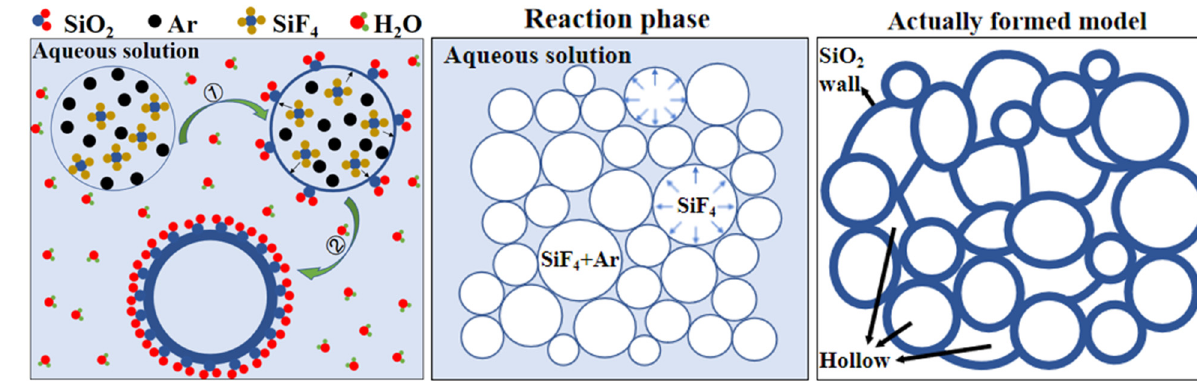
Figure 5. Growth mechanism of cellular silica in aqueous solution.